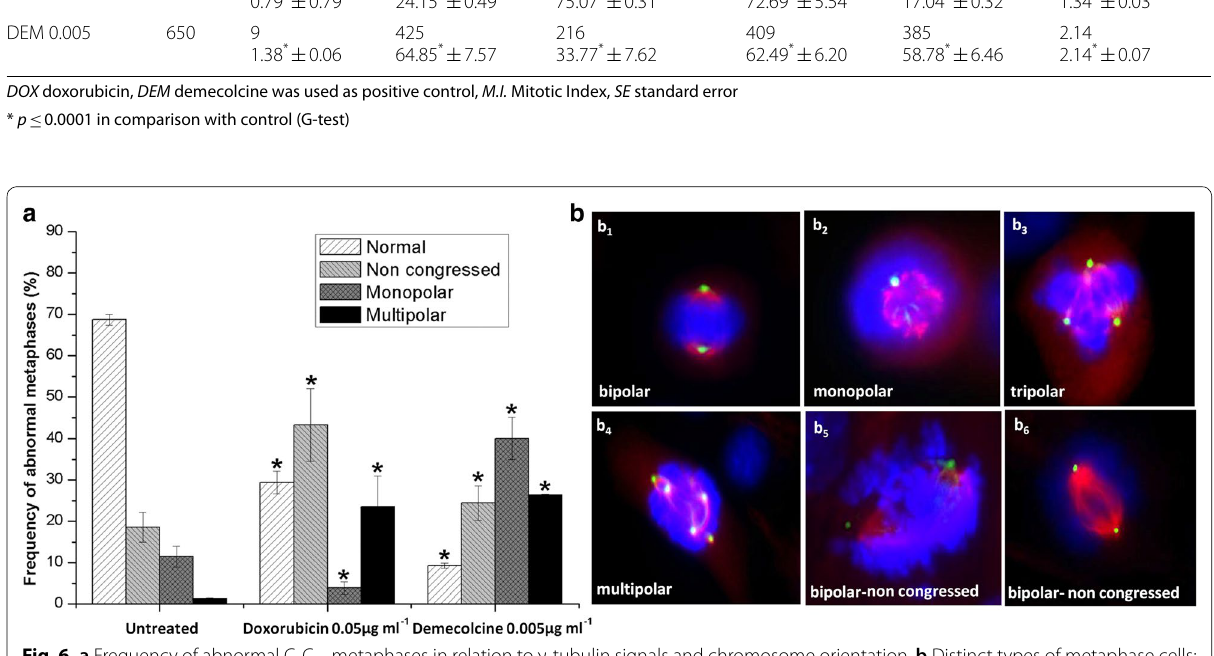
Fig. 6 a Frequency of abnormal C 2 C 12 metaphases in relation to γ-tubulin signals and chromosome orientation. b Distinct types of metaphase cells: normal metaphase ( b 1 ); monopolar metaphase ( b 2 ); tripolar metaphase ( b 3 ); multipolar metaphase ( b 4 ); and bipolar non-congressed metaphases ( b 5–6 ). * p 0.05 in comparison with control (G-test). Demecolcine was used as positive control. Bars represent standard ≤